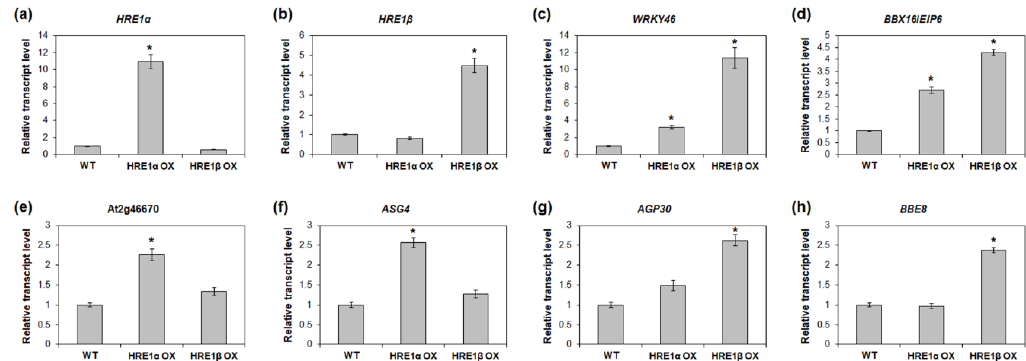
Figure 10. Expression analysis of downstream genes of HRE1α and/or HRE1β in HRE1α OXs and HRE1β OXs. Quantitative RT-PCR analysis of HRE1α ( a ), HRE1β ( b ), WRKY46 ( c ), BBX16 / EIP6 ( d ), At2g46670 ( e ), ASG4 ( f ), AGP30 ( g ), and BBE8 ( h ) in WT, HRE1α OX, and HRE1β OX seedlings. GAPc was used as an internal control. The transcript levels in WT were set as 1. Three independent reactions were performed for each technical replicate. Two technical replicates were performed for each biological replicate. At least two biological replicates showed similar results, with one shown here. The data shown are the means ± S.D. ( n = 6) and * indicates t -test p < 0.05.